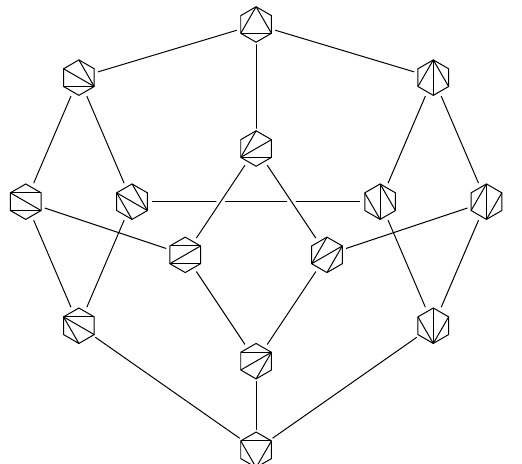
Figure 3. The cluster polytope of A triangulation of the